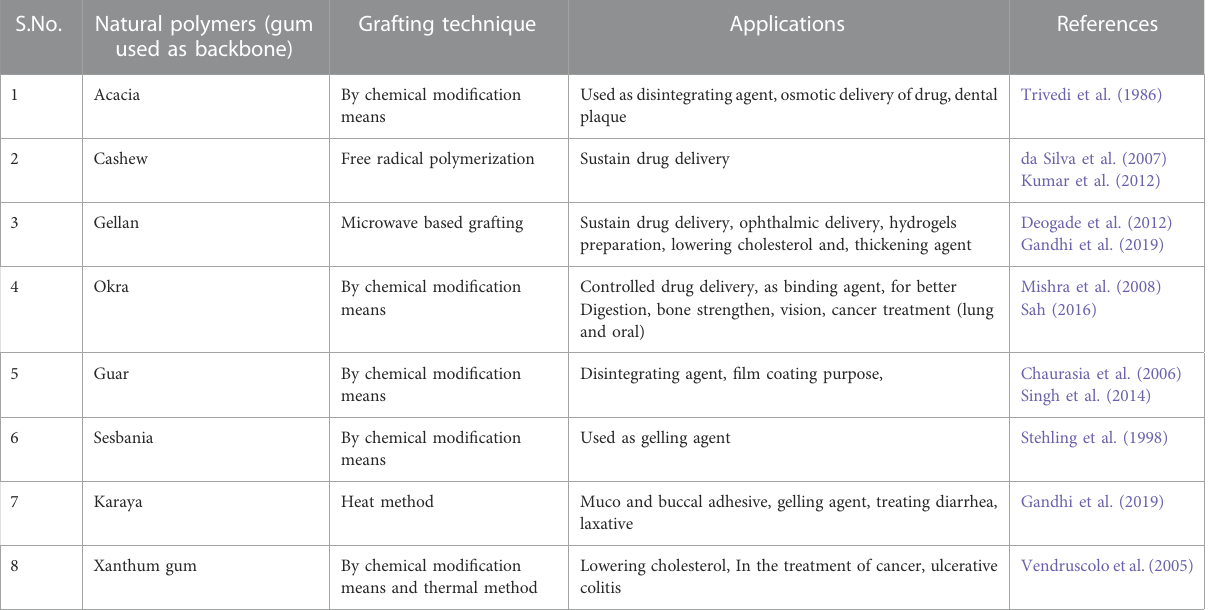
TABLE 4 Natural grafted